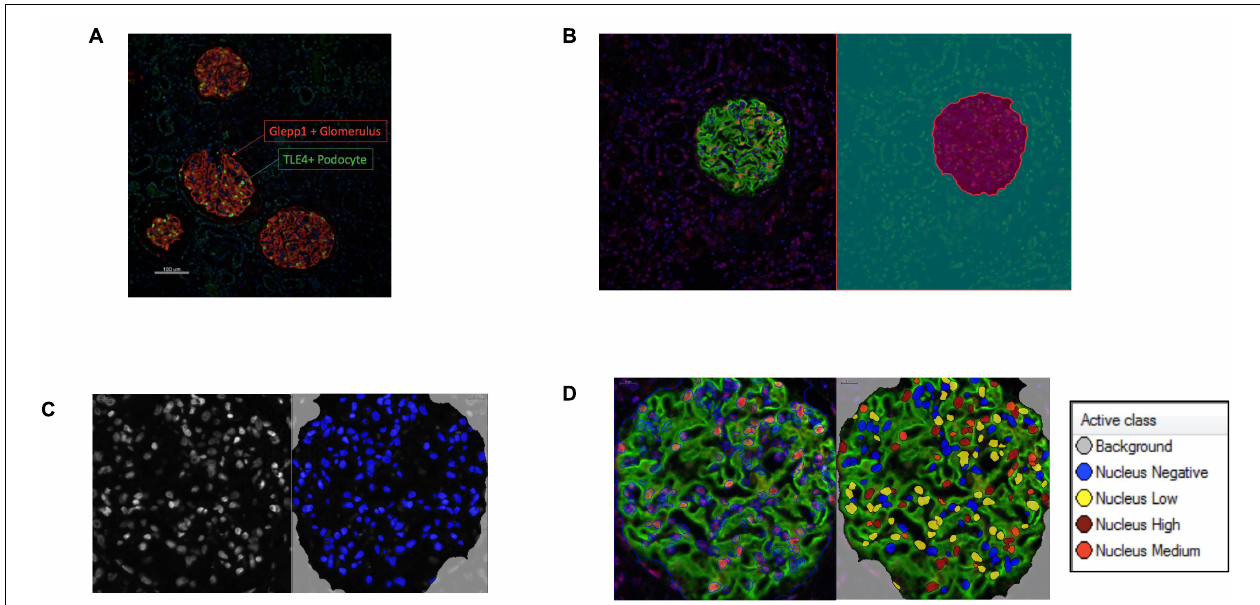
FIGURE 1 | Podometric methodology: Incorporation of automated image analysis (A) Representative image of GLEPP1 (red) and TLE4 (green) staining of glomeruli which was analyzed for podocyte density. (B) Definiens identification of Region of Interest (ROI) (magenta) based on GLEPP1 staining. (C) Hoechst staining is used to segment nuclei within ROI with Definiens. (D) Within segmented nuclei, TLE4 expression is used to identify nuclei with low (yellow), medium (orange), and high (red) TLE4 expression levels. Based on a manually determined TLE4 expression threshold, all TLE4-expressing nuclei within the ROI are determined to be podocytes.